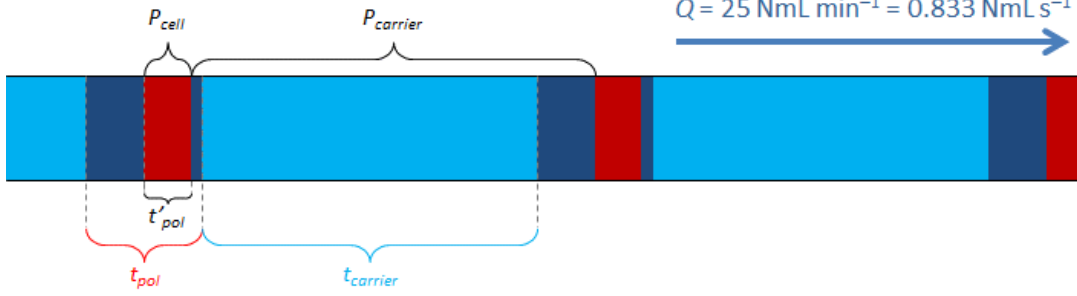
Figure 2. Schematic drawing of the flow composition and pressure exiting the mixing generator. The usual total flow rate is Q = 25 NmL min −1 .